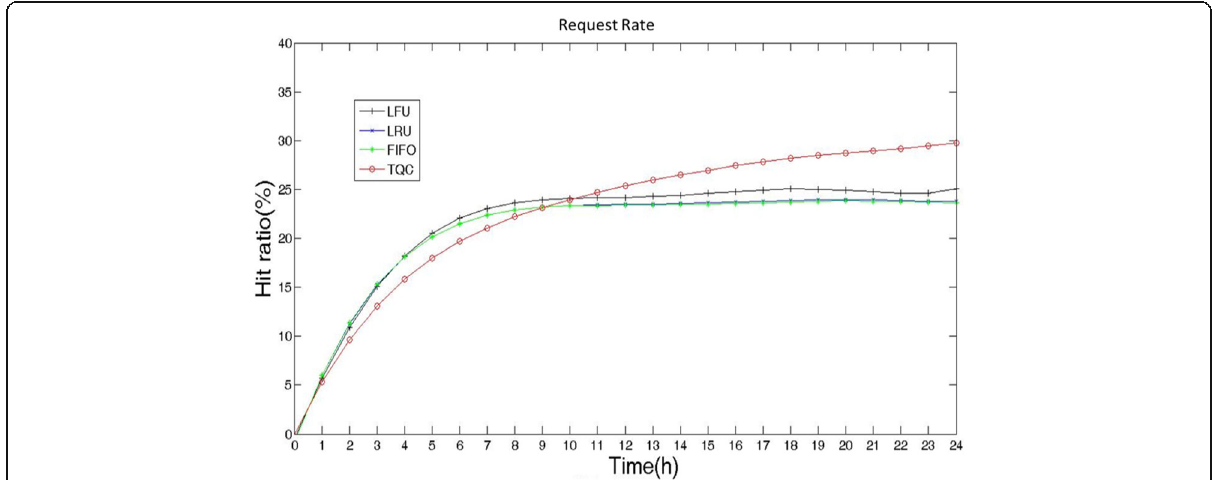
Fig. 4 Request rate evaluation. The figure shows the hit ratios of different policies when cache capacity C is 32 GB and request rate is 250